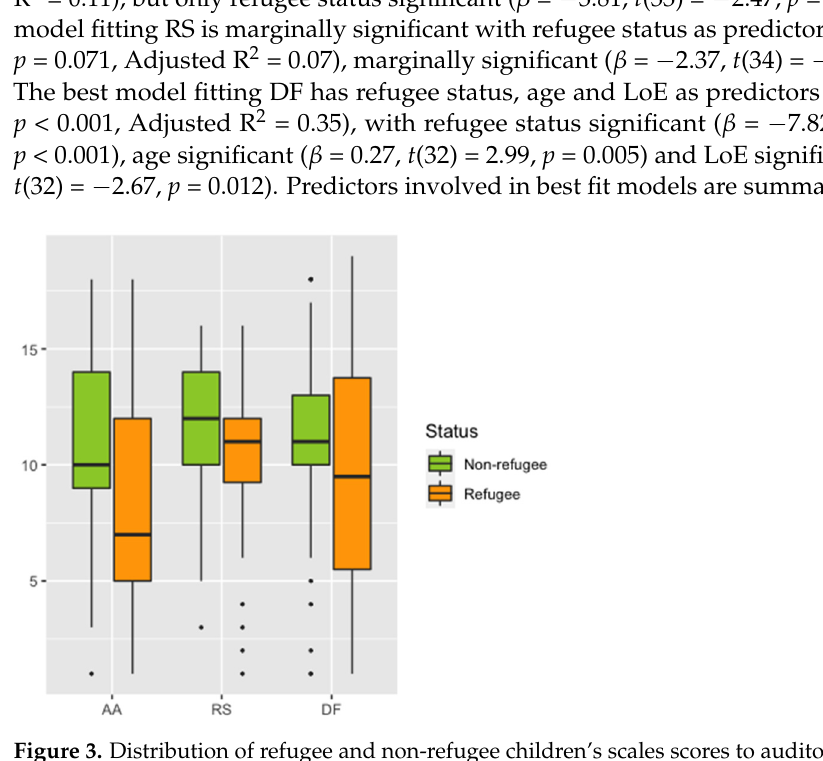
Figure 2. Distribution of refugee and non-refugee children’s scaled scores to the forward span (FWS) and backward span (BWS).